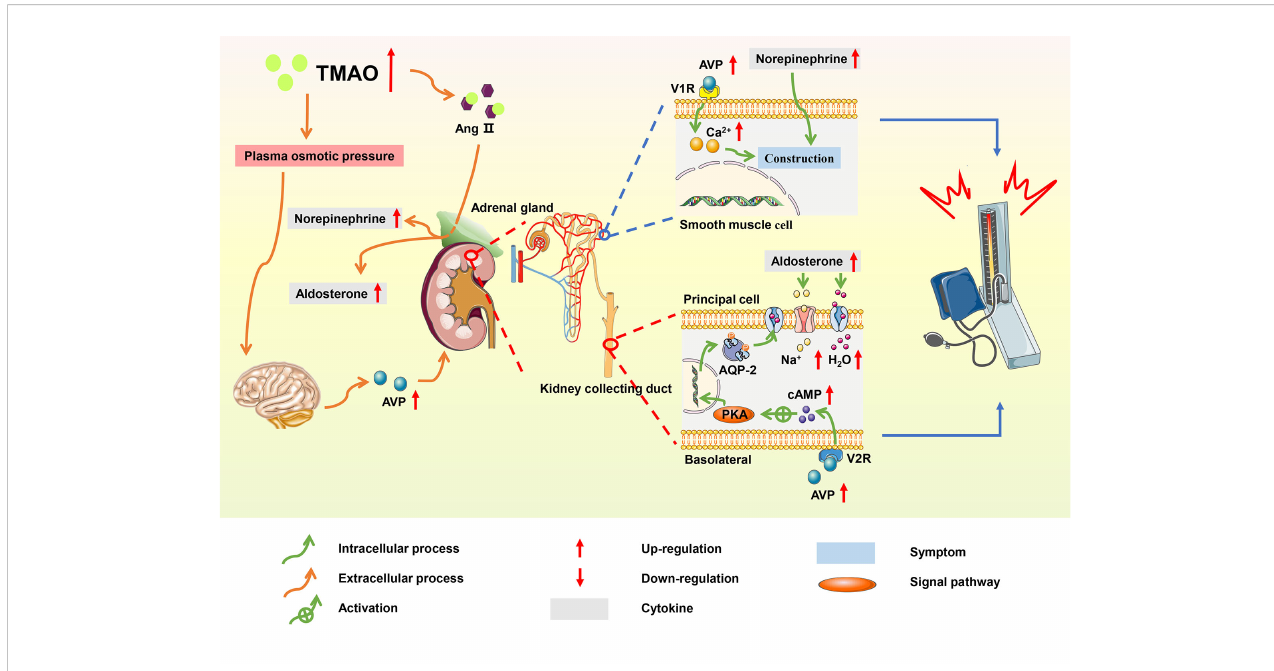
FIGURE 5 Summary schemes illustrating the involvement of TMAO in hypertension. TMAO prolonged the hypertensive effect of Ang II, and elevated blood pressure via RAAS; TMAO stimulated the secretion of AVP, increasing water reabsorption through the ‘ TMAO-AVP-AQP-2 Axis ’ , which contributed to the progression of